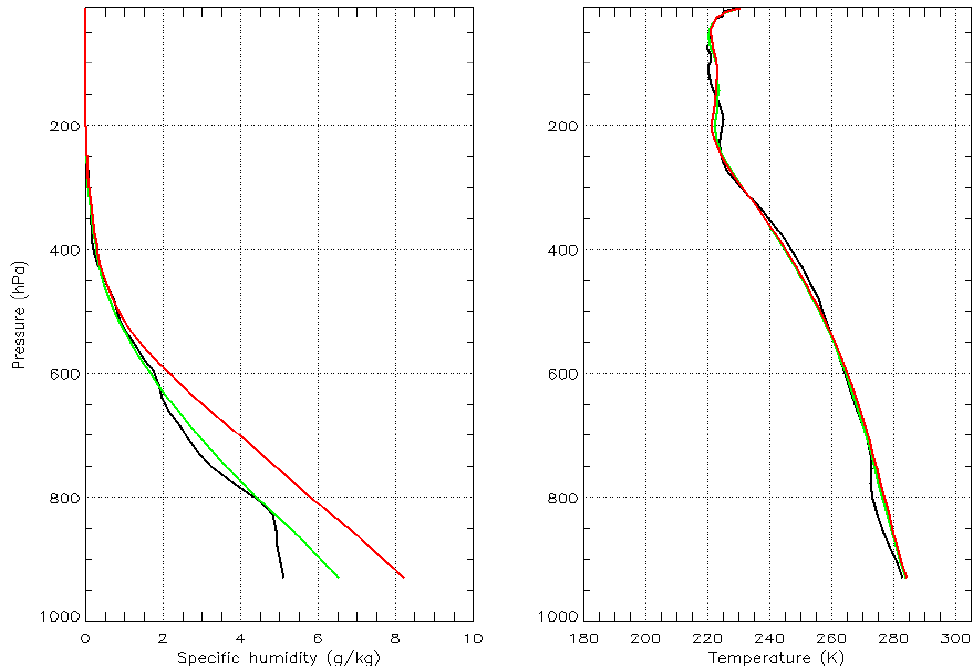
Figure 2. A case of a MiRS ATMS operational product. The black line is the ECMWF data (reference). The green line is the operational MiRS retrieval and the red line is the MiRS experimental test without ATMS channel 1.